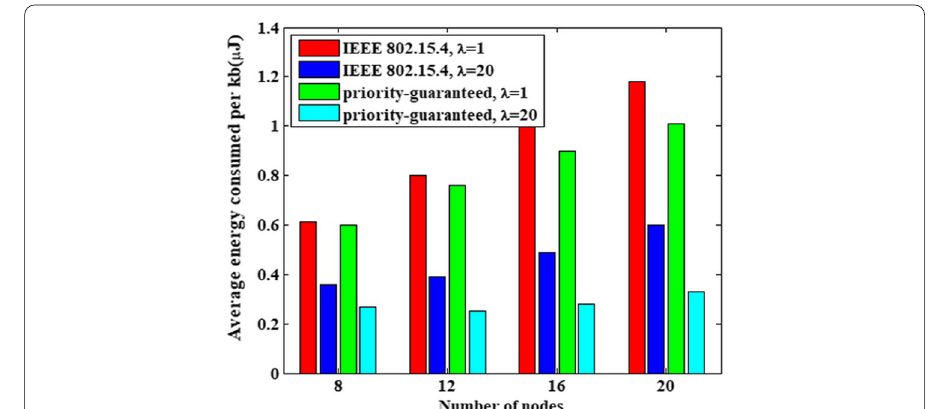
Fig. 10 Average energy consumed versus number of nodes